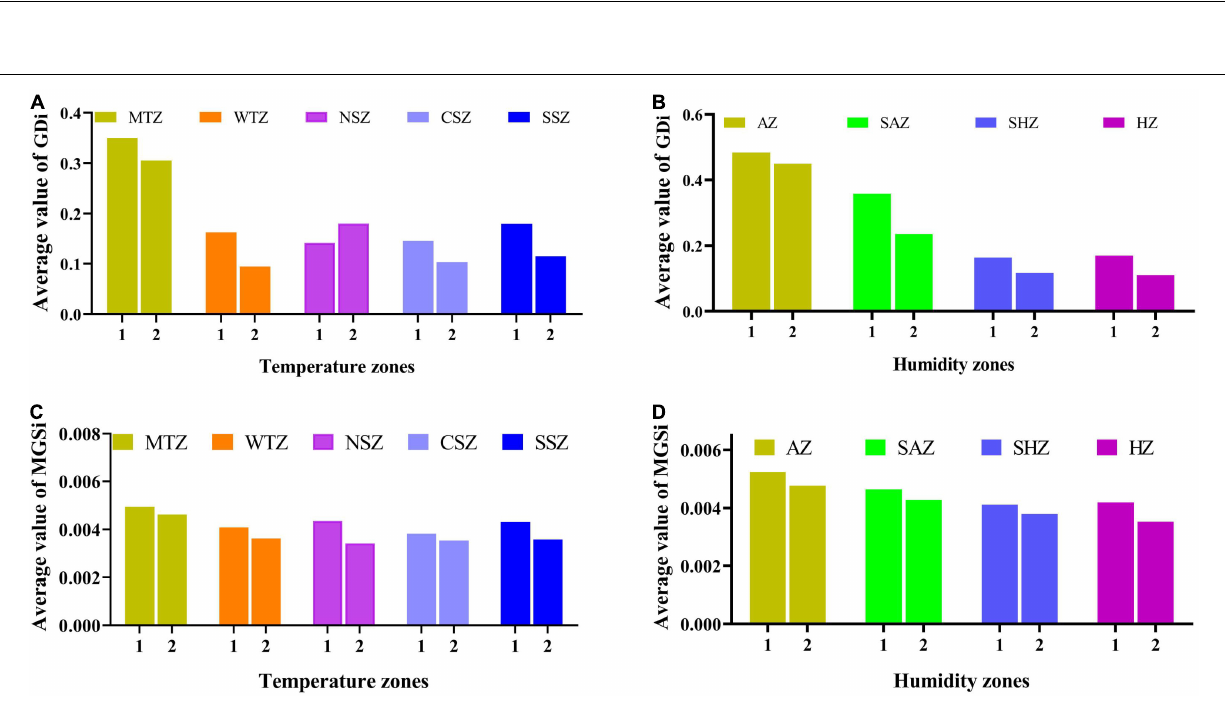
FIGURE 4 | Comparison of the average value of the GDi and MGSi in different temperature and humidity zones. (A,B) the average value of the GDi in temperature zones and humidity zones; (C,D) the average value of the MGSi in temperature zones and humidity zones; numbers 1 and 2 on the x -axis denote prefecture-level and county-level cities,